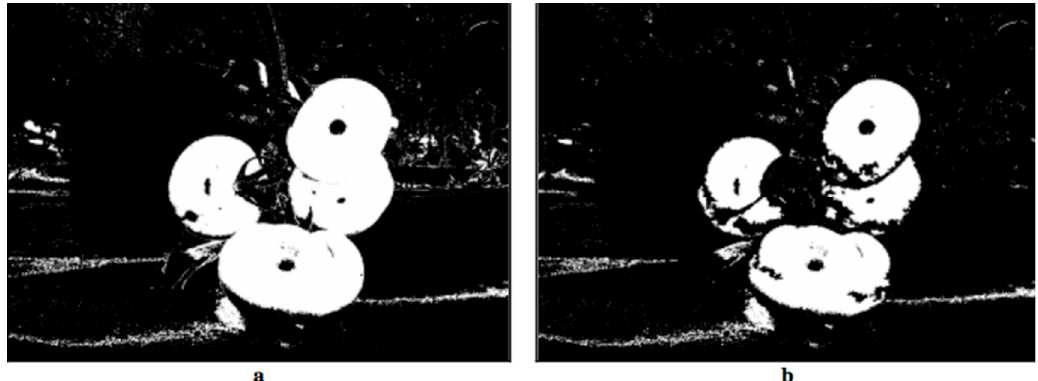
obtained). Figure 9. ( a ) Original image; and ( b ) segmentation based on color 1 (the whole ripe surface is obtained).